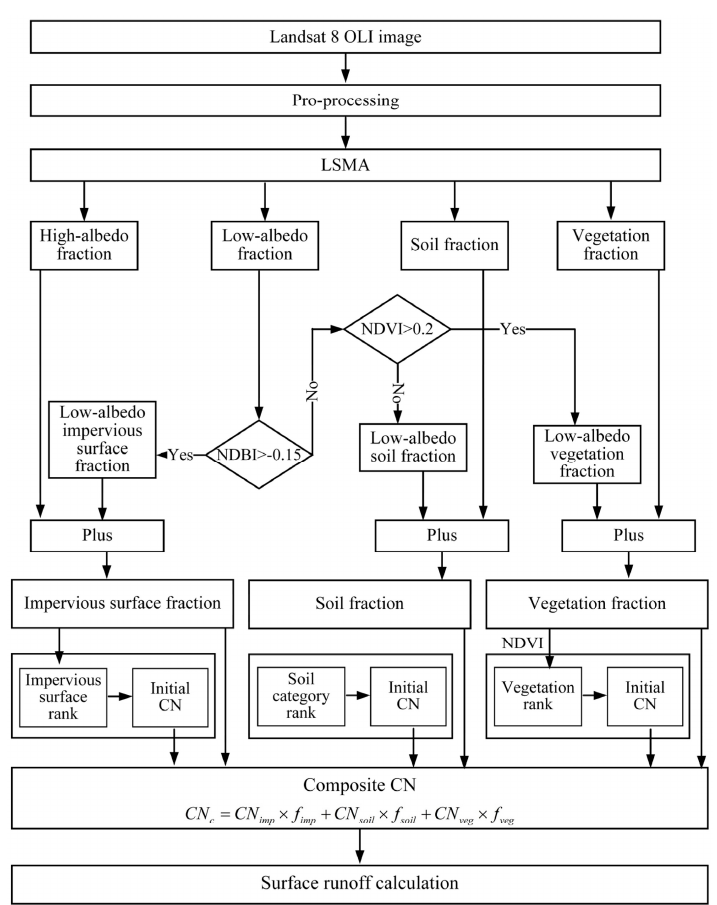
Figure 3. Flow chart for the surface runoff estimation in this study. LSMA: Linear Spectral Mixture Analysis; NDVI: Normalized Difference Vegetation Index; NDBI: Normalized Difference Built-up Index; CN: Curve Number; OLI: Operational Land Imager